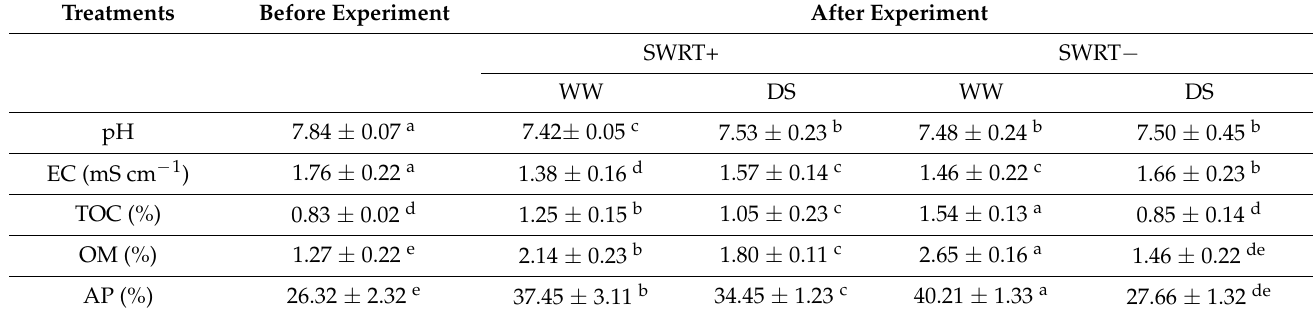
Figure 3. Effects of water regimes (DS: drought stress or WW: well-watered) on shoot and root ( A ) superoxide dismutase (SOD), ( B ) catalase (CAT), ( C ) ascorbate peroxidase (POX) activities, and ( D ) total phenolic content (TPC) subjected to treatments. SWRT − : without subsurface water retention technology (SWRT); SWRT+: with SWRT. Data represented are mean of three replicates ± standard error (SE) (n = 3). Different letters in the same column show significant difference at p < 0.05. Table 3. Effect of subsurface water retention technology (SWRT) on main characteristics of different treatments on agricultural soil physicochemical parameters before and after